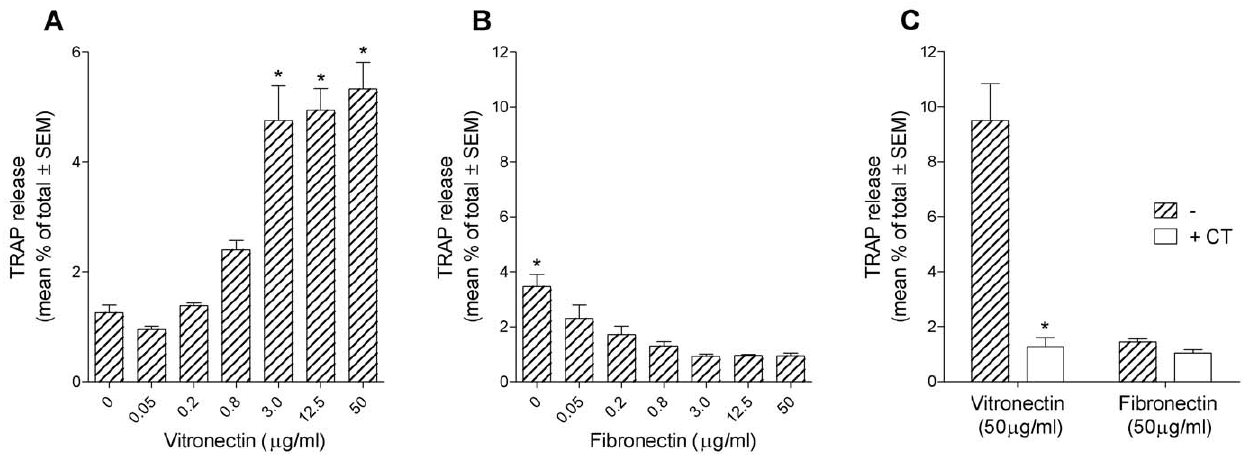
Figure 1. Vitronectin induces TRAP release by osteoclasts. Bone marrow-derived osteoclasts were sedimented in MEM/2.5% FCS onto coverslips that had been coated with the vitronectin or fibronectin at the concentrations shown. After 20 minutes, the coverslips were washed and incubated for 5 hours in MEM containing 2.5% FCS, M-CSF (50 ng/ml), RANKL (30 ng/ml) and IL-1 a (10 ng/ml), and with/without salmon calcitonin (CT) (100 pg/ml). TRAP was then measured in the supernatant and lysate. n=5 cultures per variable. A, B: *p , 0.05 versus 0 group (A) or versus all other groups (B); ANOVA plus Dunnett’s post-test. C: *p , 0.05 versus no CT. ANOVA followed by Bonferroni post-test.